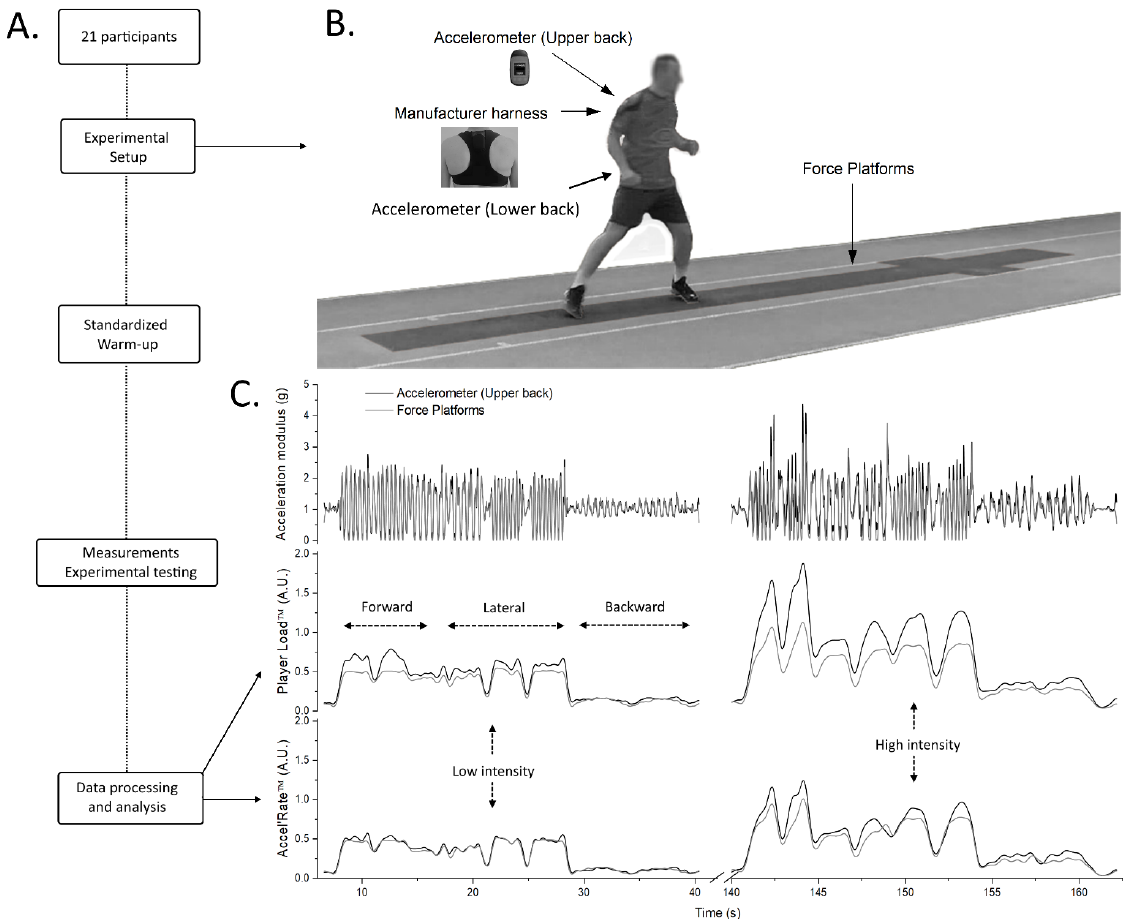
Figure 1. Overview of the experimental design, instrumentation setup and measurements from the concurrent validity protocol. ( A ): Experimental procedure. ( B ): Representation of the force plates area (total length of 6.6 m) and the position of the accelerometers. ( C ): Typical examples of acceleration modulus (top layer), Player Load (middle layer) and Accel’Rate (bottom layer) metrics during the general locomotor movements (GLM) at low (left) and high (right) intensity. Data were obtained from the in-series force plates (light grey traces) and the accelerometer positioned at the upper back (black traces; classical position used in